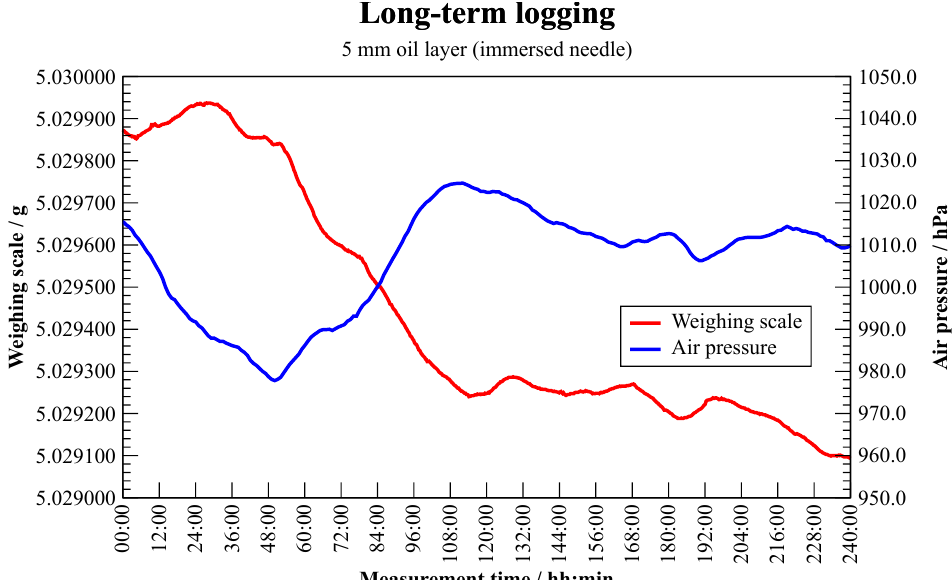
Figure 6. Long-term test of evaporation over 10 days while the beaker was filled with 10mm water and 5mm oil film and the needle was